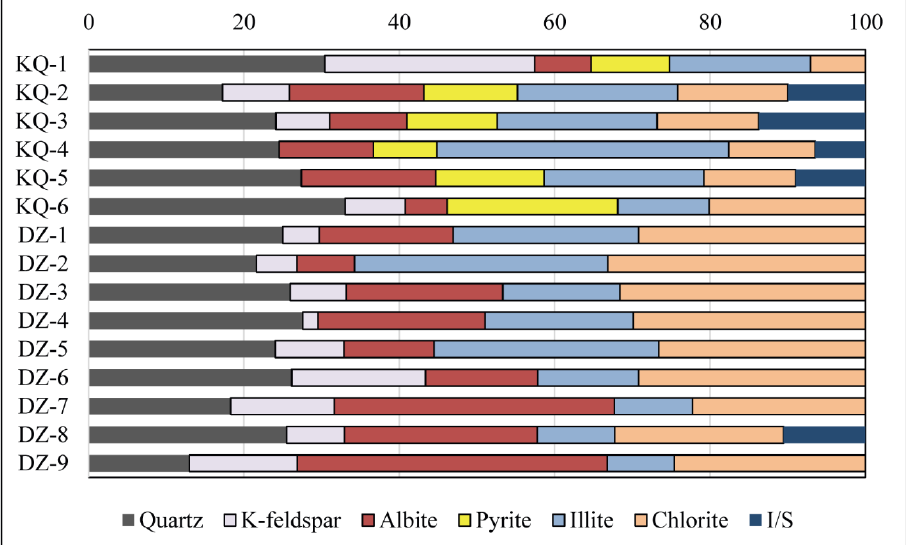
Figure 2. Mineralogical compositions of the studied Chang 7 Member shale samples determined by X-ray diffraction. I/S = illite/smectite interlayers.